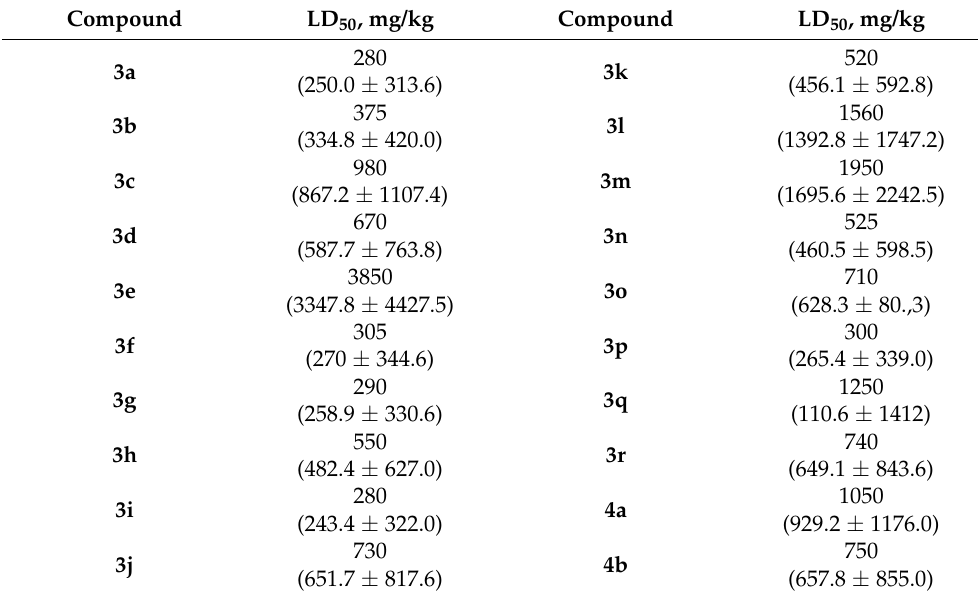
Table 3. Acute toxicity of the studied compounds in mice after intragastric administration (N =